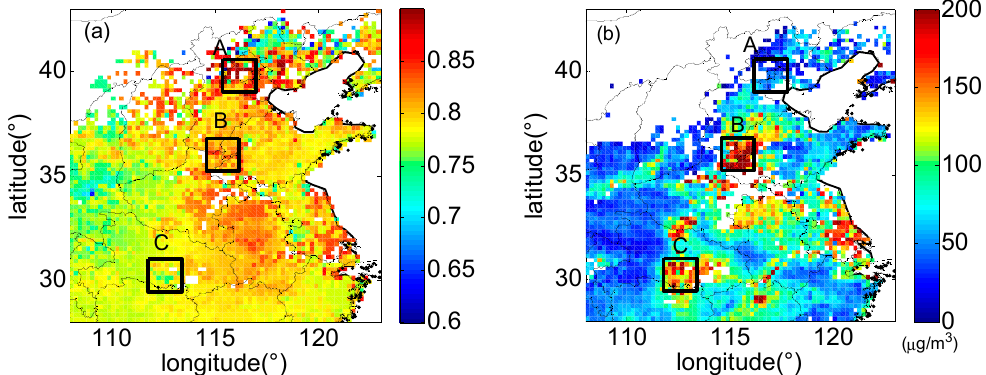
Figure 8. ( a ) The mean FMF fusion results in the Winter of 2015 and the three regions in black squares; and ( b ) the mean PM 2.5 estimated from the FMF fusion results in the Winter of 2015 (there is no result in the time period from 26 January 2015 to 1 February 2015 because of the lack of data pairs).